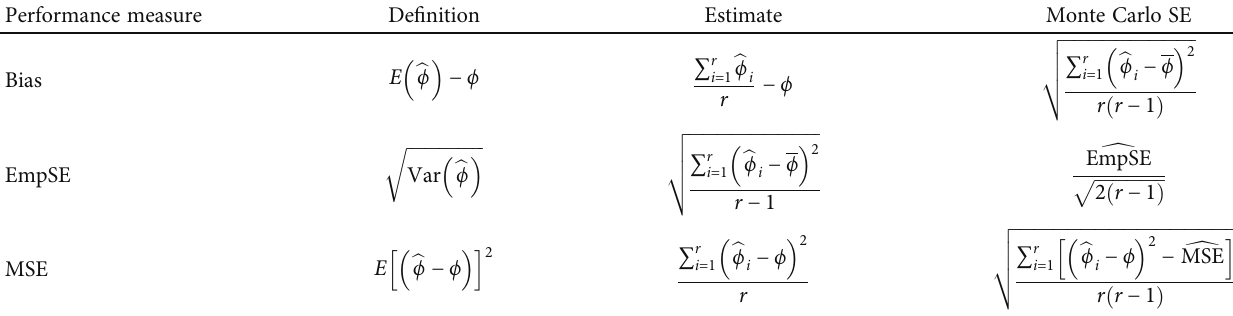
Figure 7: Sampling distributions of b μ Table 3: Expressions of performance measures and their Monte Carlo SE where r is the number of replications. Performance